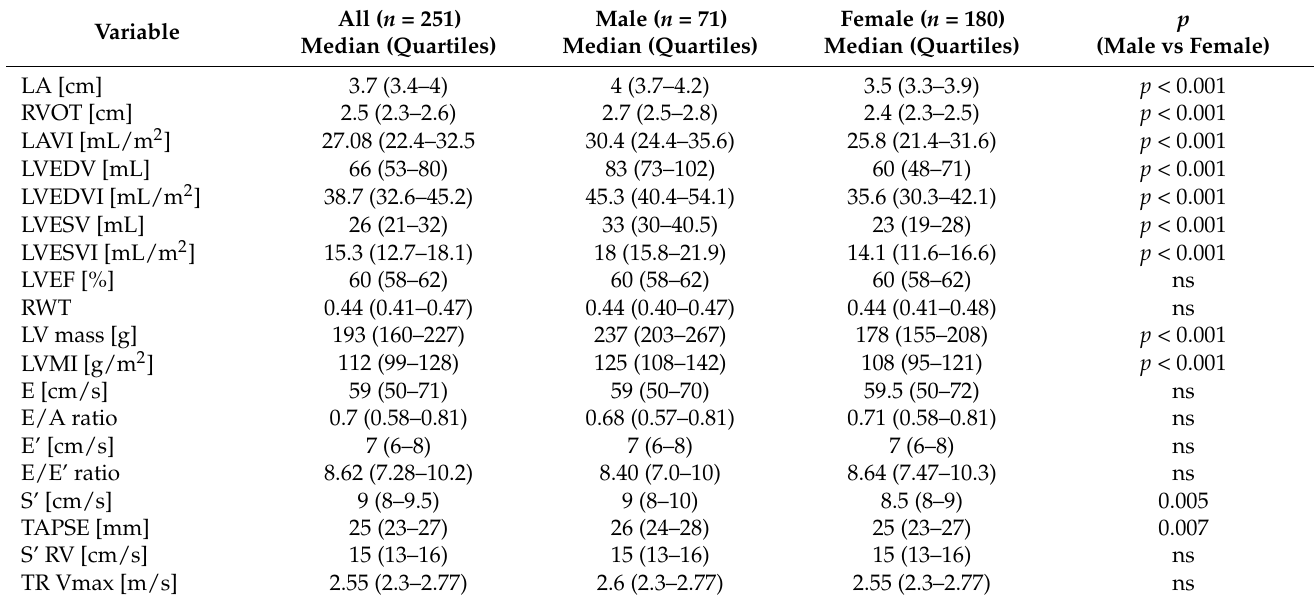
Table 2. General characteristics of echocardiographic parameters according to sex.